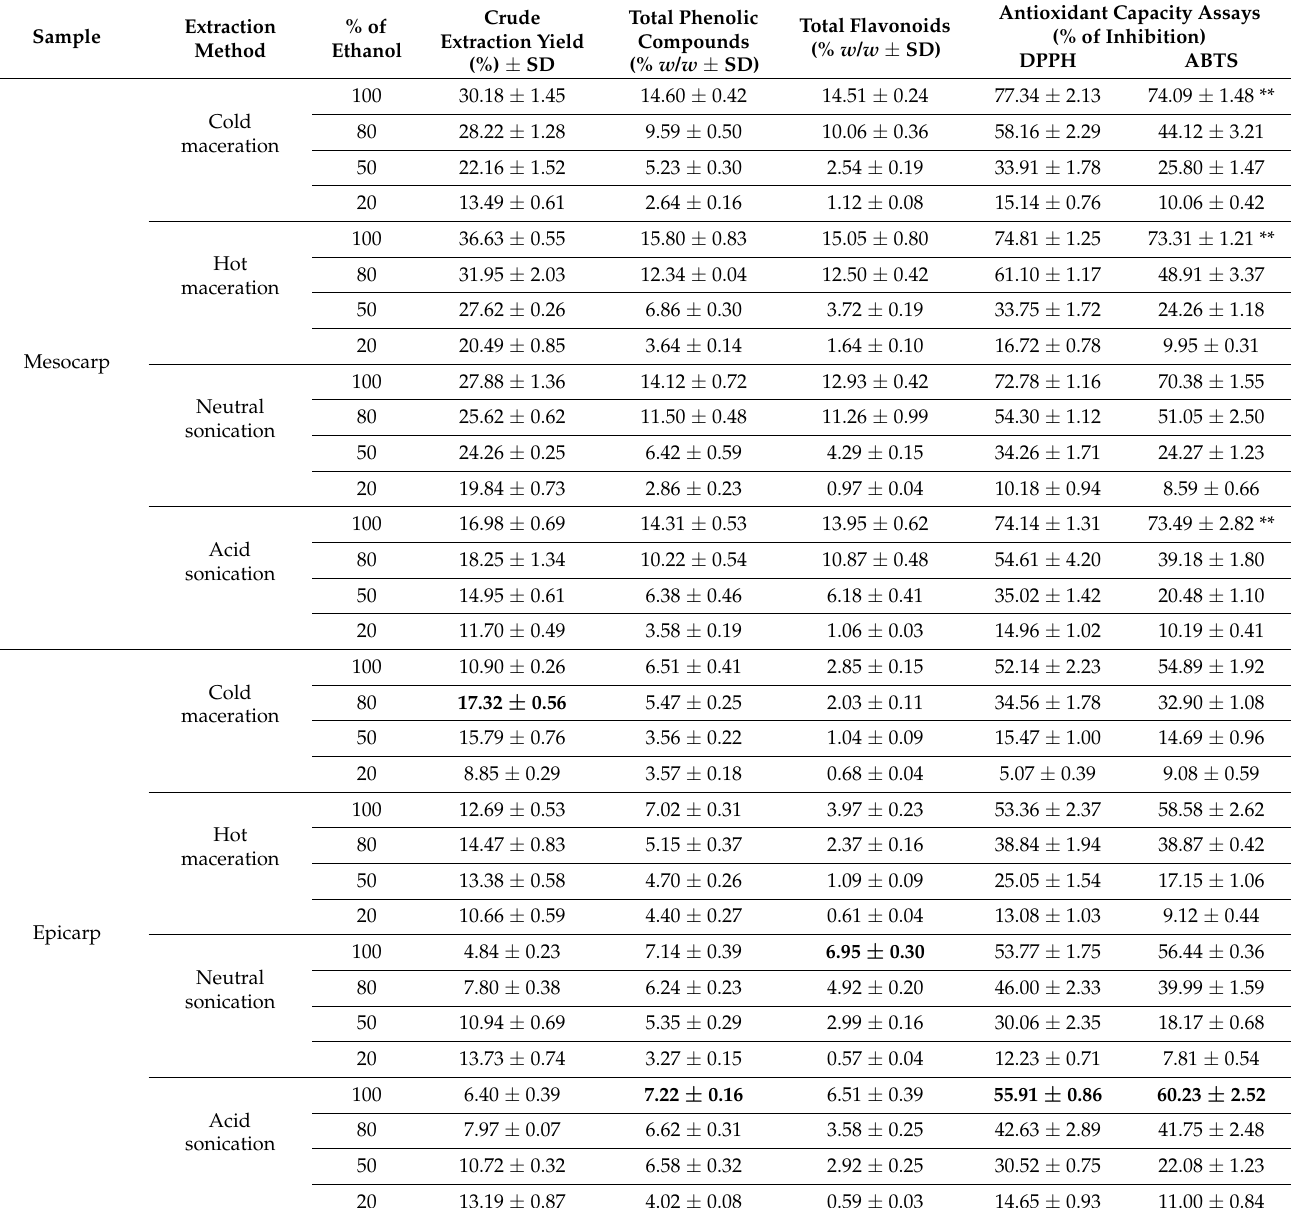
Table 1. Results of extractions carried out with different methods at different ethanol percentages in water on the mesocarp and epicarp of bacuri. Sample